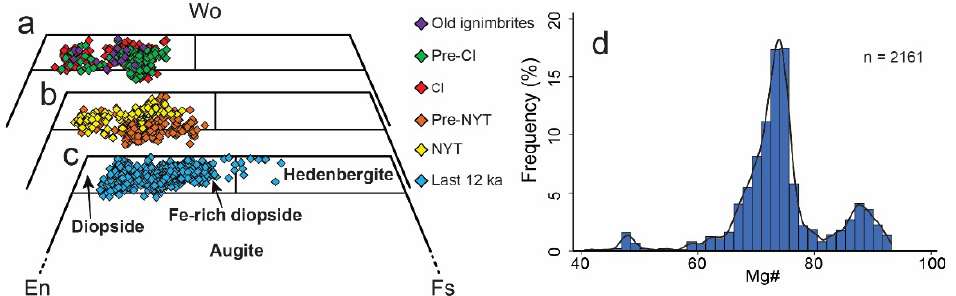
Figure 4. Di-Hd-En-Fs ( a – c ) classification diagram and ( d ) Mg# frequency histogram showing the distribution of Campi Flegrei clinopyroxene composition. Di = diopside; Hd = hedenbergite; En = enstatite; Fs = ferrosilite. Table 1. Ranges of Mg# values of clinopyroxene crystals belonging to different periods of Campi Flegrei activity.